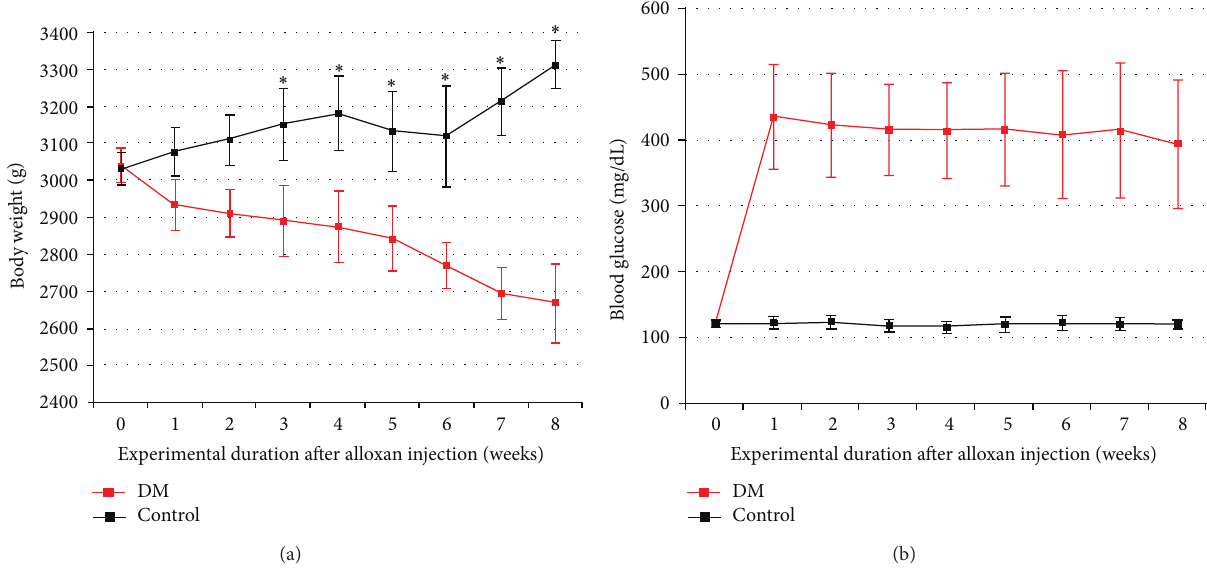
Figure 1: Comparison between the changes of the rabbit’s weight in the control (black) and diabetic (red) groups throughout the 8-week experimental period. (a) An asterisk ( ∗ ) represents a significant difference ( 𝑃 < 0.05 ). (b) The line graph represents the blood glucose levels for the control (black) and diabetic (red) groups. The blood glucose level in the diabetic group increased significantly 1 week after injection of alloxan monohydrate and remained increased for the rest of the experimental period ( 𝑃 < 0.05